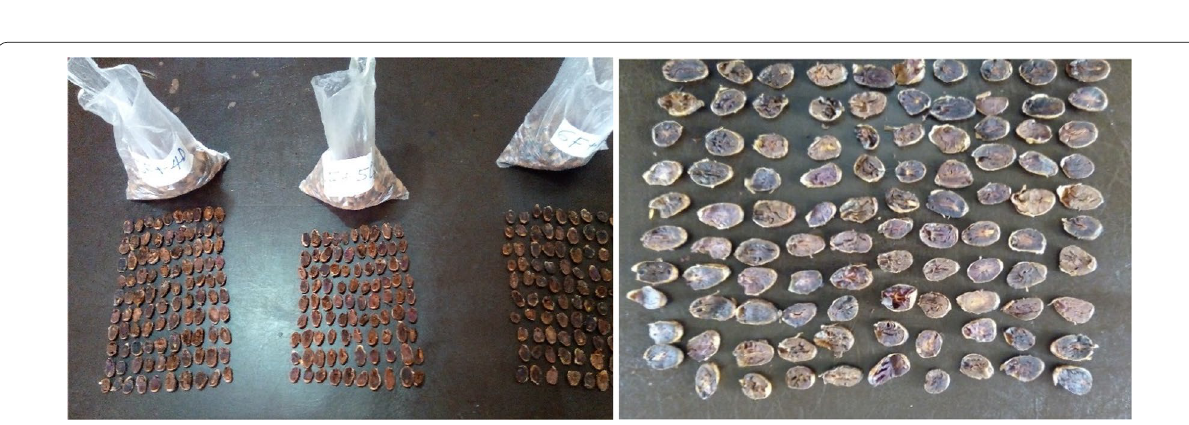
Fig. 3 Cross longitudinal section of cut cocoa beans for identifying defective beans after